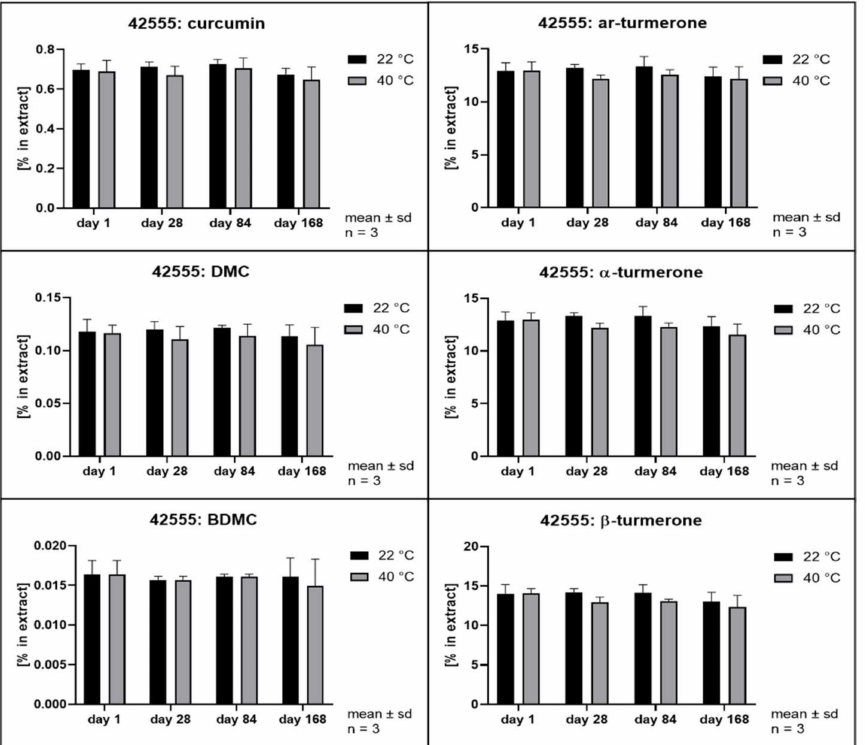
Figure 11. Contents of individual curcuminoids and turmerones in scCO 2 extracts throughout storage, extraction at 425 bar and 55 ◦ C .